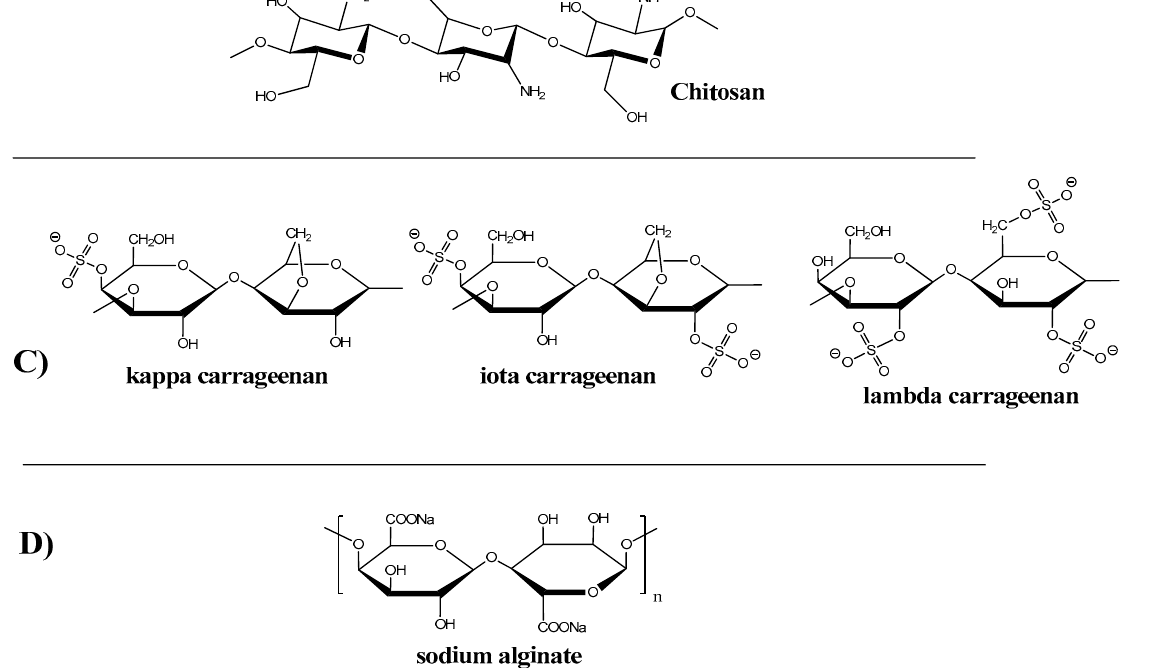
Figure 2. Chemical structure of polysaccharides polymers and their derivatives. ( A ) Cellulose and Its Derivatives; ( B ) Chitin and Chitosan; ( C ) Carrageenan; ( D ) Alginate.